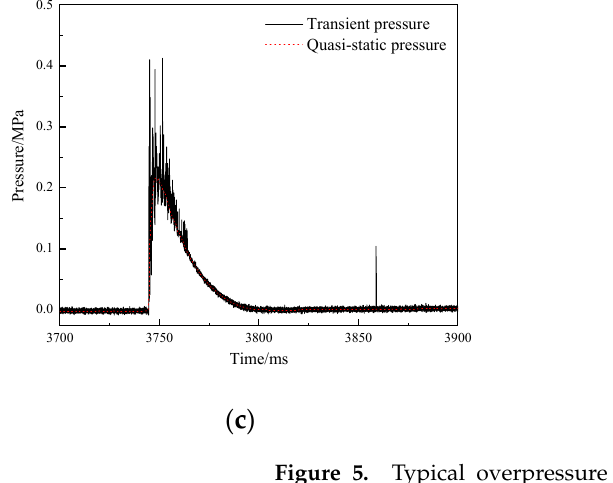
Figure 5. Typical overpressure versus time in the closed bomb vessel: ( a ) 26.5% Al/73.5% PTFE − 1880 m/s ( b ) 5.29% Al/80% W/14.71% PTFE − 1150 m/s ( c ) 62% Hf/38% THV − 1500 m/s ( d ) 88% Hf/12% THV − 1100 m/s.